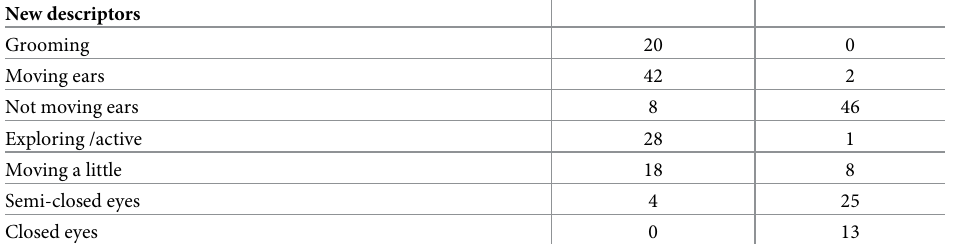
Table 3. Results from the analysis of the video clips. The number in each column (Before; After) corresponds to the number of video clips in which each descriptor was observed. Some of the descriptors were rejected because a they were ambiguous (n = 11); b they described changes over time (n = 6); c they implied relationships with or action towards another rabbit or a person (n = 10); d they were not seen in any of the video clips (n = 12); e they did not differ- entiate between before and after surgery (n = 7). The new descriptors were recorded under the categories “New descriptors”. BEFORE AFTER Demeanour Alert/responsive (No pain word) 50 2 Depressed 0 7 Quiet 5 43 Disinterested 0 5 Dull 1 8 Lethargic 0 8 NOT grooming themselves 30 47 Hiding e 5 4 Rejected: Unresponsive d Cowering at the back of the cage a , Biting c , Aggressive c Grumpy a Restless a , Lashing out to a person c , Lunging c , Isolate c , Withdrawn a , Allow to be handled c Posture/Locomotion Relaxed/comfortable (No pain word) 47 0 Hunched 1 18 Tense posture 1 12 Still 7 47 Inactive 7 44 Rejected: Belly pressing d Reluctant to move c , Reduced mobility b Facial Expression Open eyes (No pain word) 49 12 Flattened ears 0 3 Eyes tightened 0 3 Rejected: Whiskers forward/stand-out e Squinting eyes a , Furrowed brows a , Flattened whiskers a , Wide eyes a , Frowning a , Nasal flare a Food intake/toileting Eating (No word pain) 23 0 Passing urine/faeces (in the litter tray) (No pain word) 12 7 Anorexia 29 50 Rejected: No faeces e Lack of appetite, Eating less b , Reduced appetite b , Altered toileting b , Inappropriate urination b , Perineal soaking c , Reduced faeces b Attention to the painful area � Rejected: Lack of attention/ignoring (No pain word) e , Licking the wound/painful area d , Biting the wound/painful area d , Chewing the wound/painful area d , Attention to the wound/painful area d , Overgrooming d , Reaction as response to palpation c , Flinching as response to palpation c Audible � Squealing